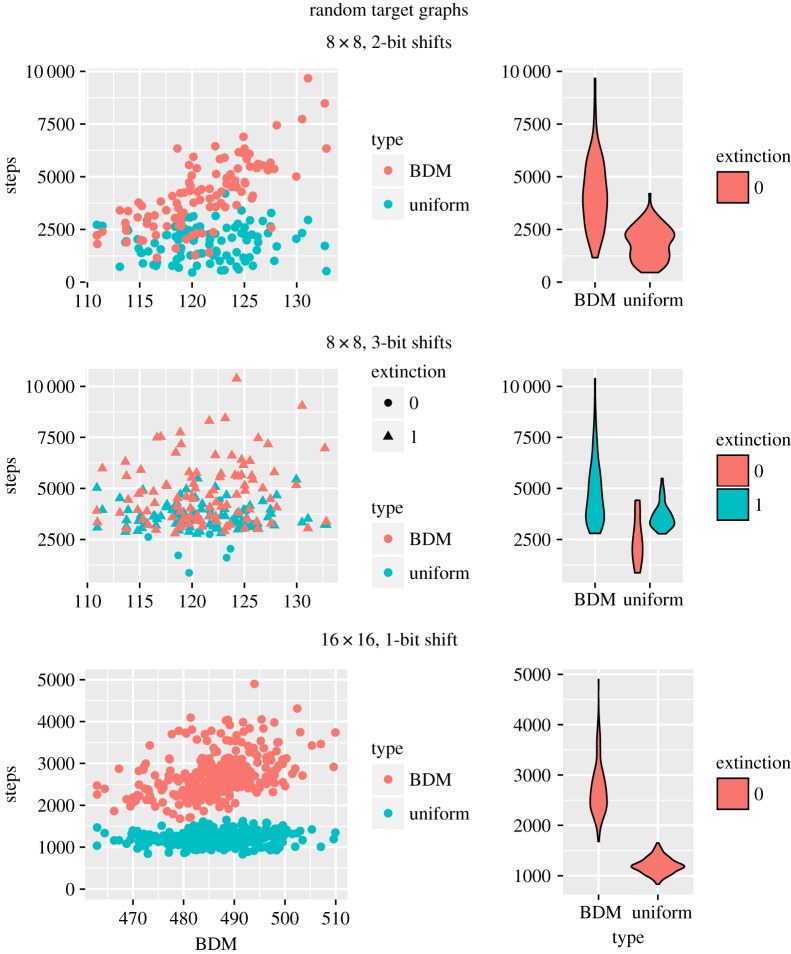
Randomly generated 8 × 8 and 16 × 16 matrices.